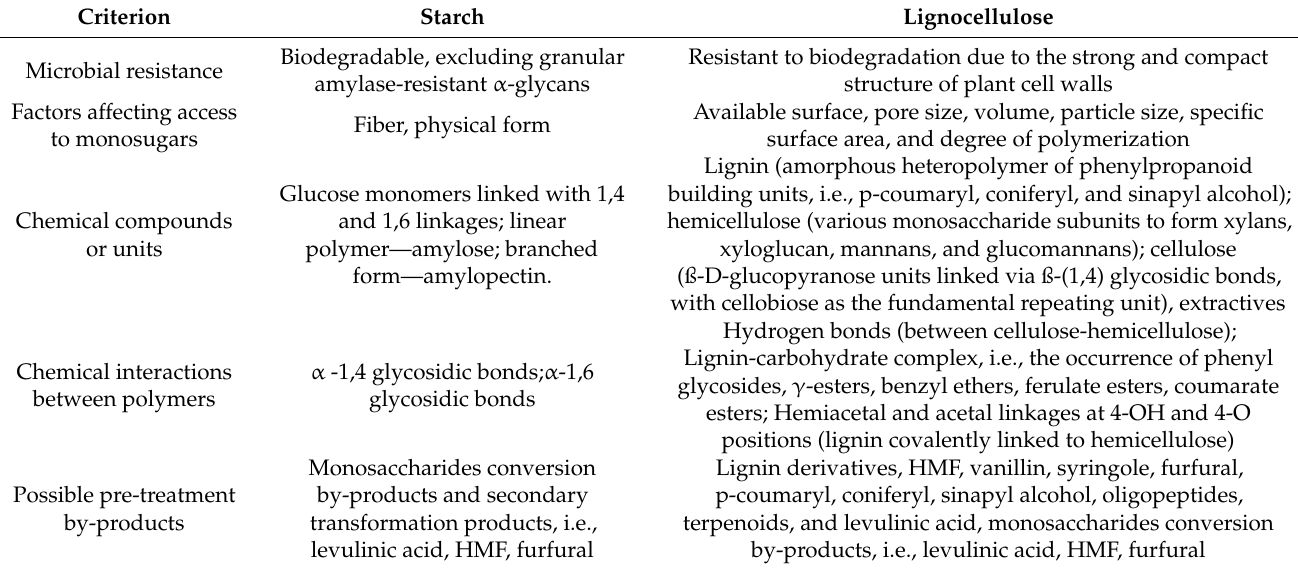
Table 1. Main features affecting the course of pretreatment of starch and lignocellulose raw